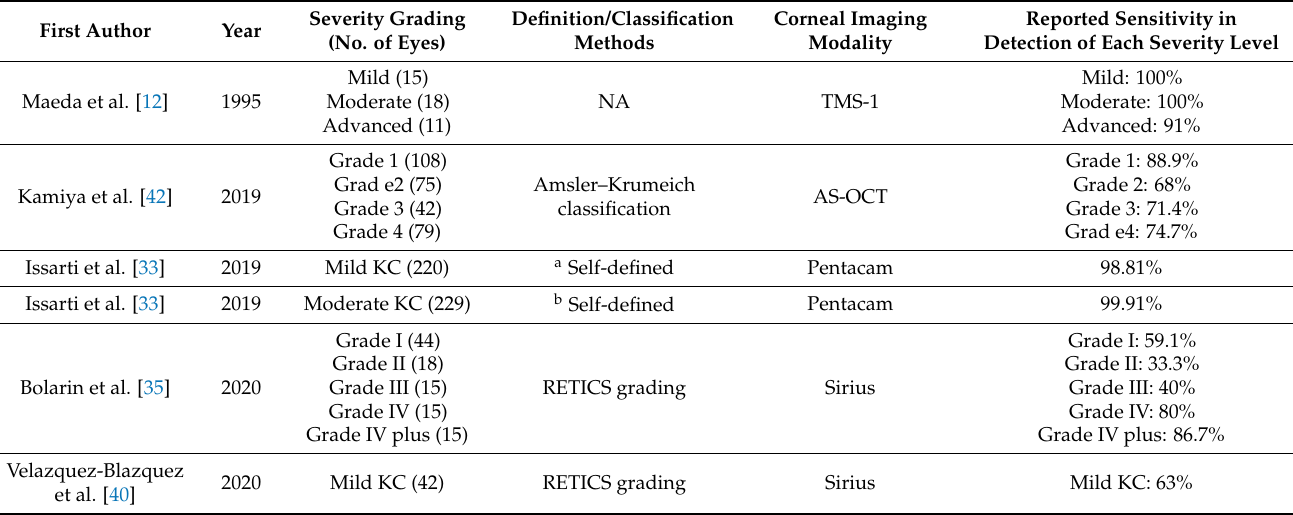
Table 4. Characteristics of machine learning-assisted studies for detection of KC